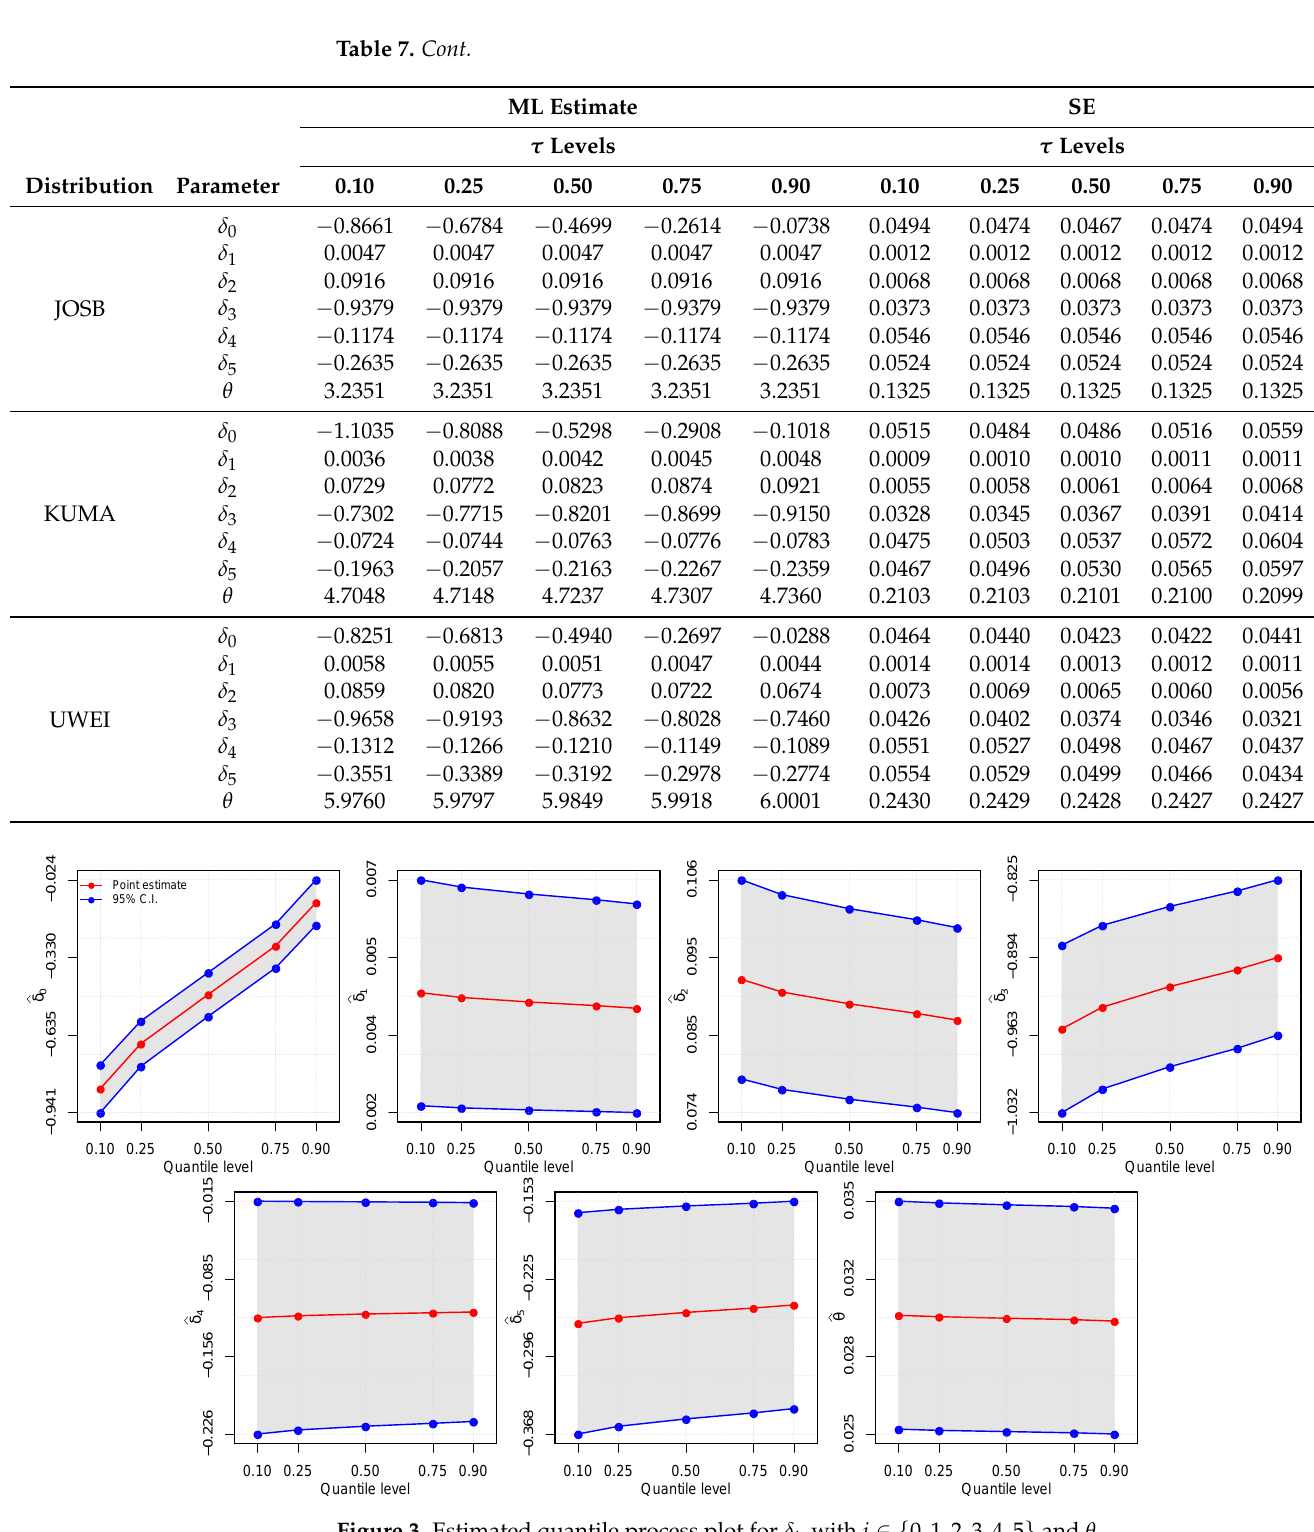
Figure 3. Estimated quantile process plot for δ i , with i ∈ { 0,1,2,3,4,5 } and θ